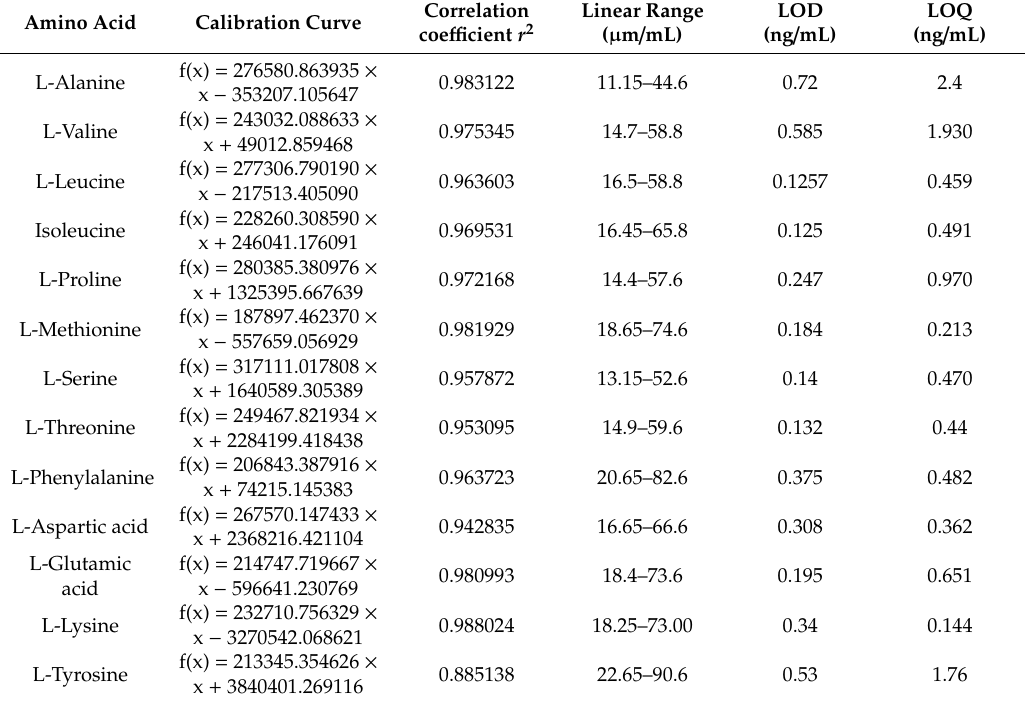
Table 2. Regression parameter, linearity, limit of detection (LOD) and limit of quantification (LOQ) of the proposed GC–MS method.